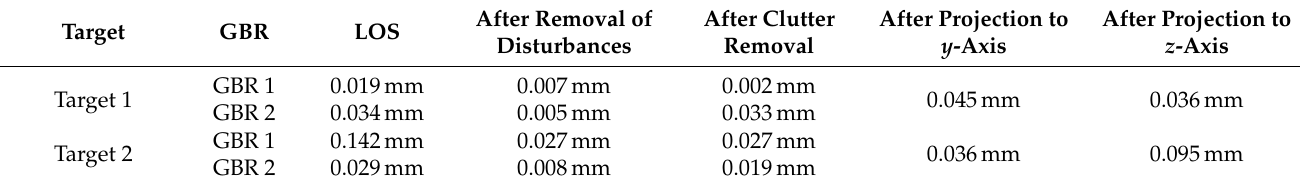
After Removal of After Clutter After Projection to After Projection to y -Axis z Disturbances Removal